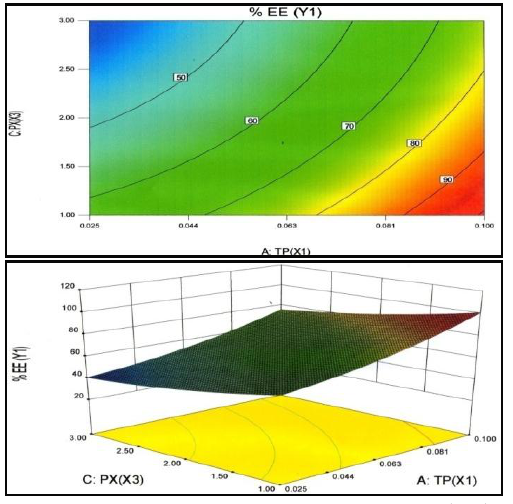
Figure 3: Response surface contour plot (Up) and 3D plot (down) for TP and PX effect on